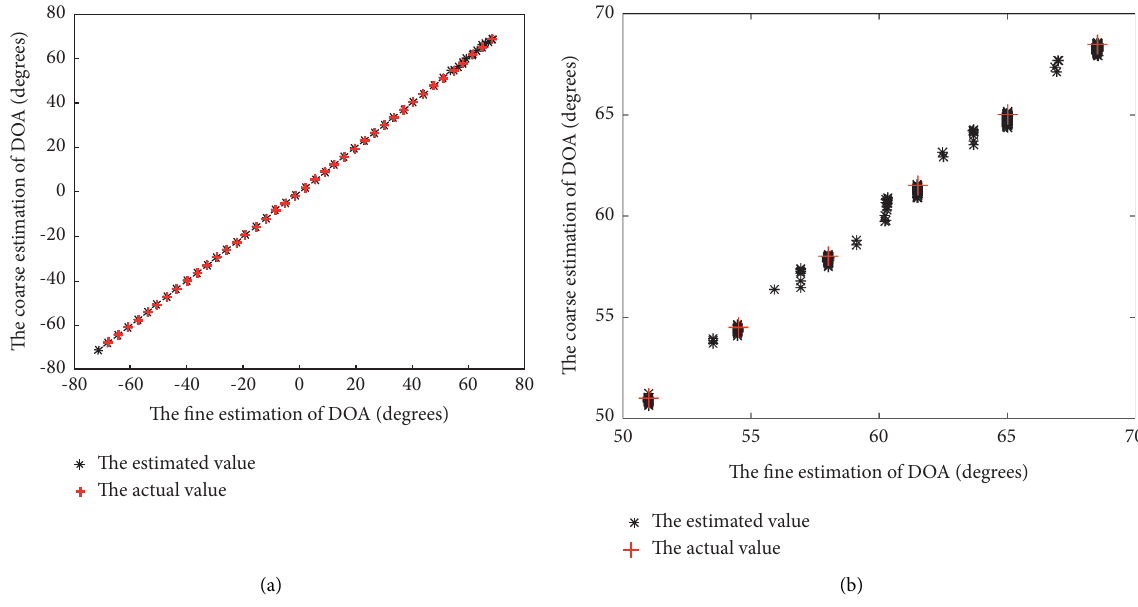
Figure 15: The simulation results of distributed nested arrays. (a) DOA estimation. (b) Partial enlarged